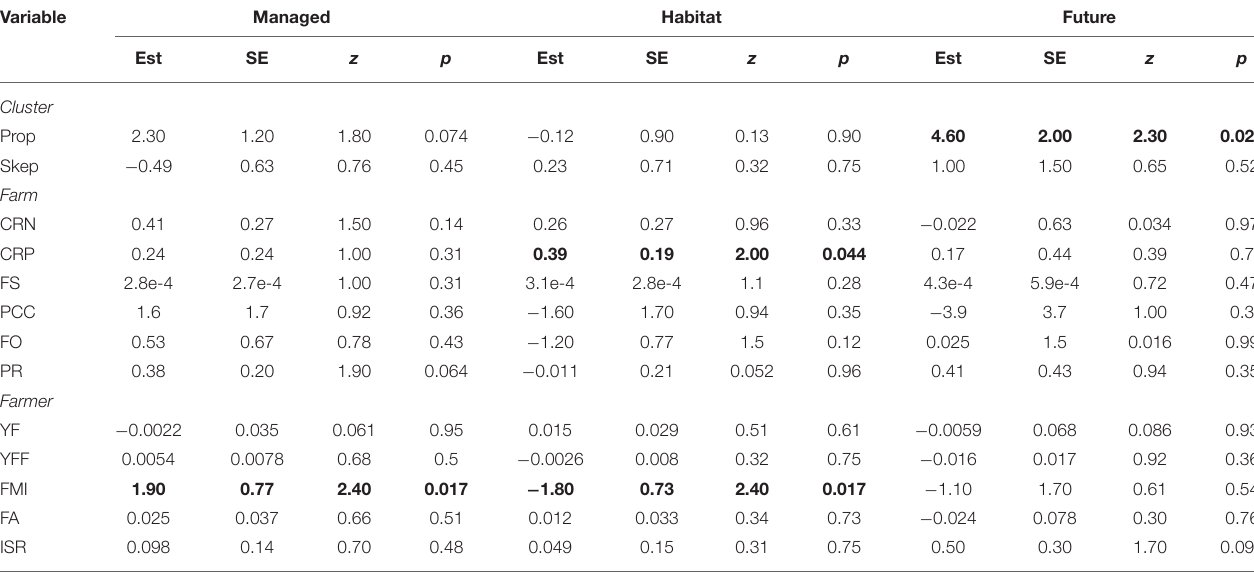
TABLE 5 | Model averaged parameter estimates, standard errors, z - and p -values for the relationship between pollinator management strategies and explantory variables (rows). Variable Managed Habitat